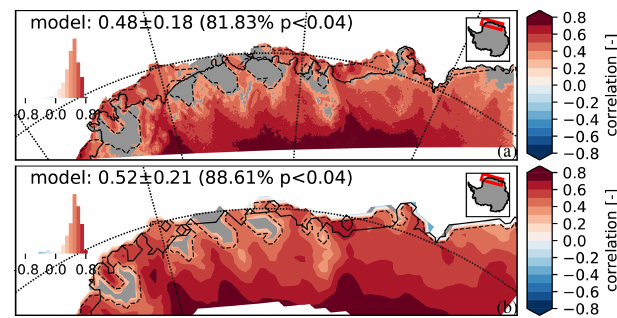
Figure 3. Annual correlation between SMB and SAT for RACMO2.3 over 1979–2016 at the (a) 5.5km and (b) 27km spa- tial resolution for Dronning Maud Land. Statistically insignificant areas ( p > p FDR , the threshold p value calculated) are in grey. The dashed black lines in both panels correspond to the areas with p > p FDR at the 27km resolution. The histogram displays the distribution of correlation values. Region-wide annual correla- tion mean, standard deviation, and percentage of model area with p < p FDR are provided in each